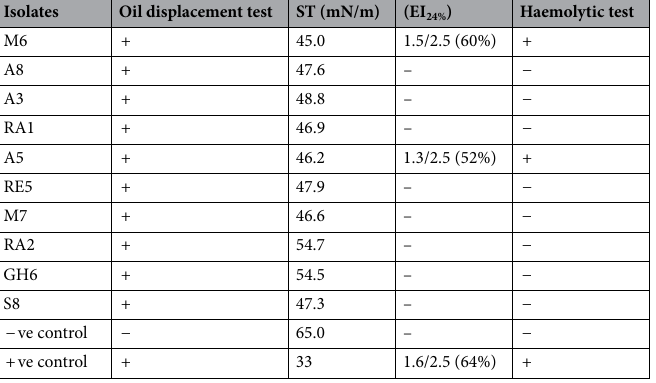
Table 2. Screening of biosurfactant-producing haloarchaea isolates. Triplet tests were performed and the average of three readings was considered as the final. − ve control is the medium while the + ve control is Tween20 at